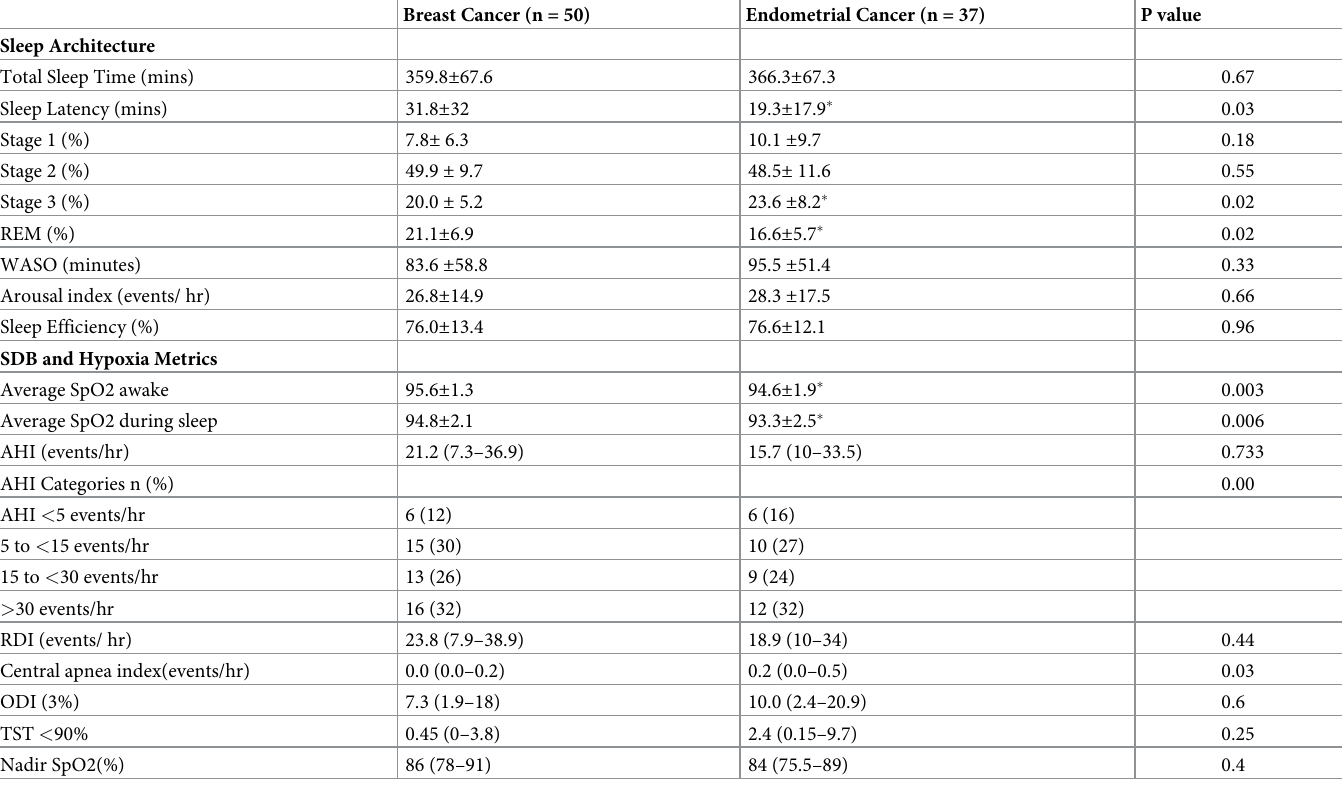
Table 3. Group average data for sleep architecture measures, hypoxia metrics and sleep disordered breathing (SDB) severity metrics for the two cancer